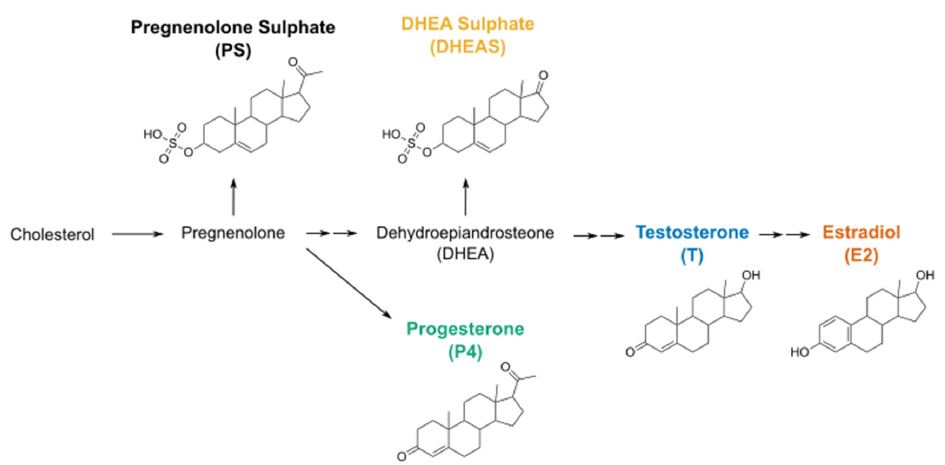
Figure 1. Simplified schematic overview of the steroidogenic pathway and molecular structures of DHEAS, estradiol (E2), progesterone (P4), and testosterone (T). As cholesterol also gives rise to other structurally related (precursor) sex hormones, like dehydroepiandrosterone sulphate (DHEAS), progesterone (P 4 ), testosterone (T), and estradiol (E 2 ), and TRPM3 is shown to be highly expressed in gonads [16,17], researchers became curious to explore whether these hormones have a modulatory effect on TRPM3 channel activity. For example, Wagner et al. tested a wide array of steroids including DHEAS, progesterone, and testosterone [8]. However, their research only identified DHEAS as a TRPM3 agonist at a concentration of 50 µM, albeit a less potent one than PS. Moreover, other research states that progesterone and estradiol can even act as inhibitors of TRPM3 [18].